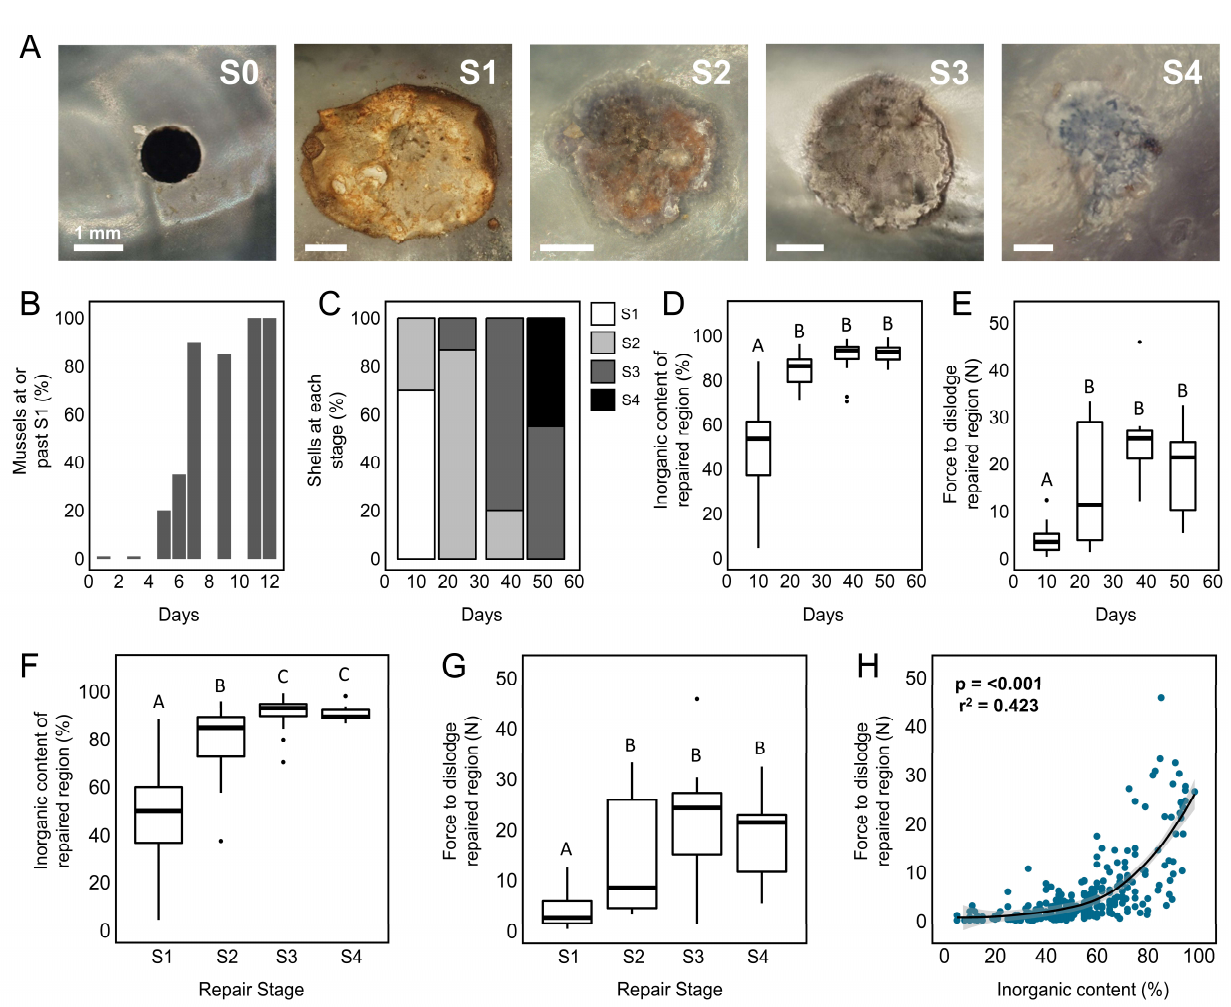
Figure 2. Time series of shell repair process. ( A ) Photographs of the interior of damaged mussel shells showing the four stereotypical repair stages (S1–S4), as defined in this study. ( B ) Proportion of mussels ( M. trossulus, n = 25) within laboratory experiments that closed drill holes (reached or exceeded S1) over 12 days. Proportion of mussels ( M. edulis, n = 15 per treatment) at each repair stage ( C ), the inorganic content of excised repaired shell ( D ), and the force required to dislodge repaired shell ( E ), from out-planted populations sampled over seven weeks in the intertidal zone. Summary of the inorganic content ( F ) and force to dislodge ( G ) repaired shell within each repair stage (pooled data from M. edulis and M. trossulus , n = 282). The relationship between the force required to dislodge repair patches and their inorganic content ( H ) across field and laboratory experiments using pooled data from both mussel species. Letters within panels indicate the results of tukey HSD post-hoc comparisons; groups that share a letter are not significantly different.